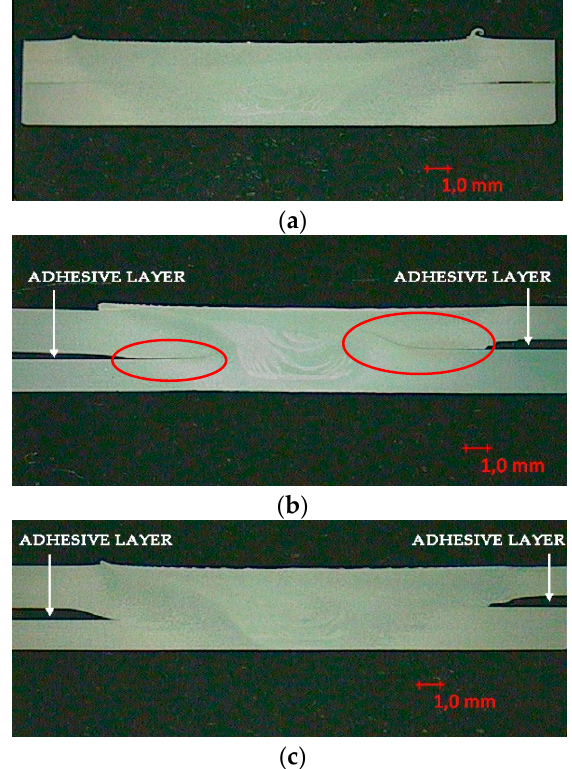
Figure 4. Macrographic inspection of: ( a ) FSW joint; ( b ) weld-through method (FSWB-WT) joint; ( c ) flow-in method (FSWB-FI) joint.